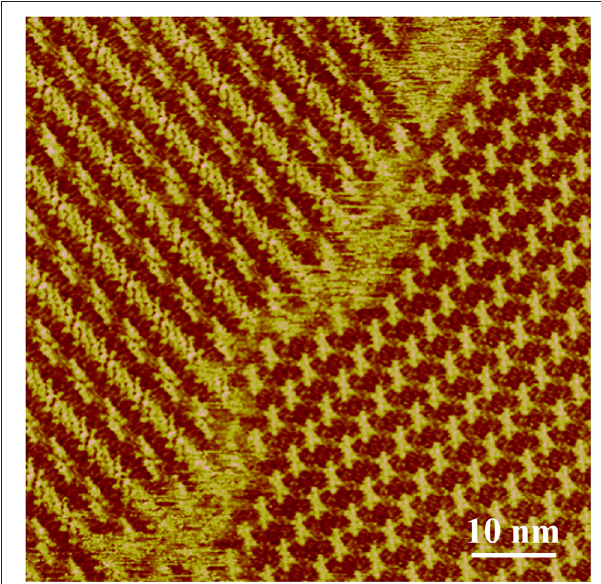
FIGURE 1 | STM images of LC-amide-1 assembly structure at the HOPG/1-phenyloctane interface at higher concentration (10 − 4 ∼ 10 − 3 M). Tunneling conditions: I set = 265.5pA, V bias = 667.4mV.